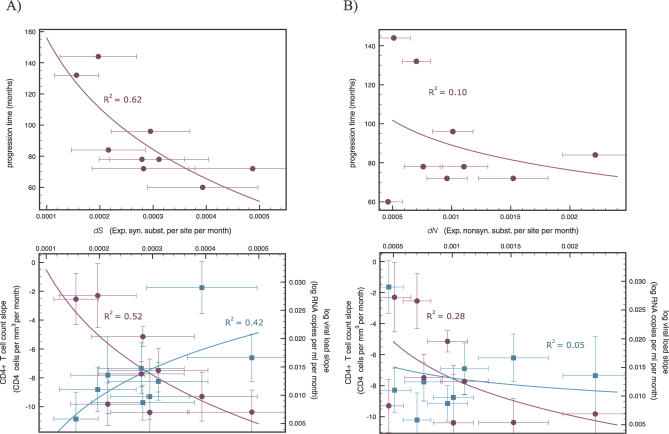
Scatter Plots of Mean Synonymous (A) and Nonsynonymous (B) Substitution Rates on Backbone Branches as a Function of Progression Time, CD4+ T Cell Count Slope, and Log Viral Load SlopeRates as a function of progression time and the slope of the CD4+ T cell count are shown in pink, while rates as a function of the log VL slope are shown in cyan. The progression time for patient 11 was set at the last sampling time (144 months), although the CD4+ count had not dropped below 200 cells/μl at that time [14,17]. The slope of the CD4+ T cell count and log VL were calculated based on linear regression of these parameters as a function of time. The error bars represent the standard errors of the estimates.